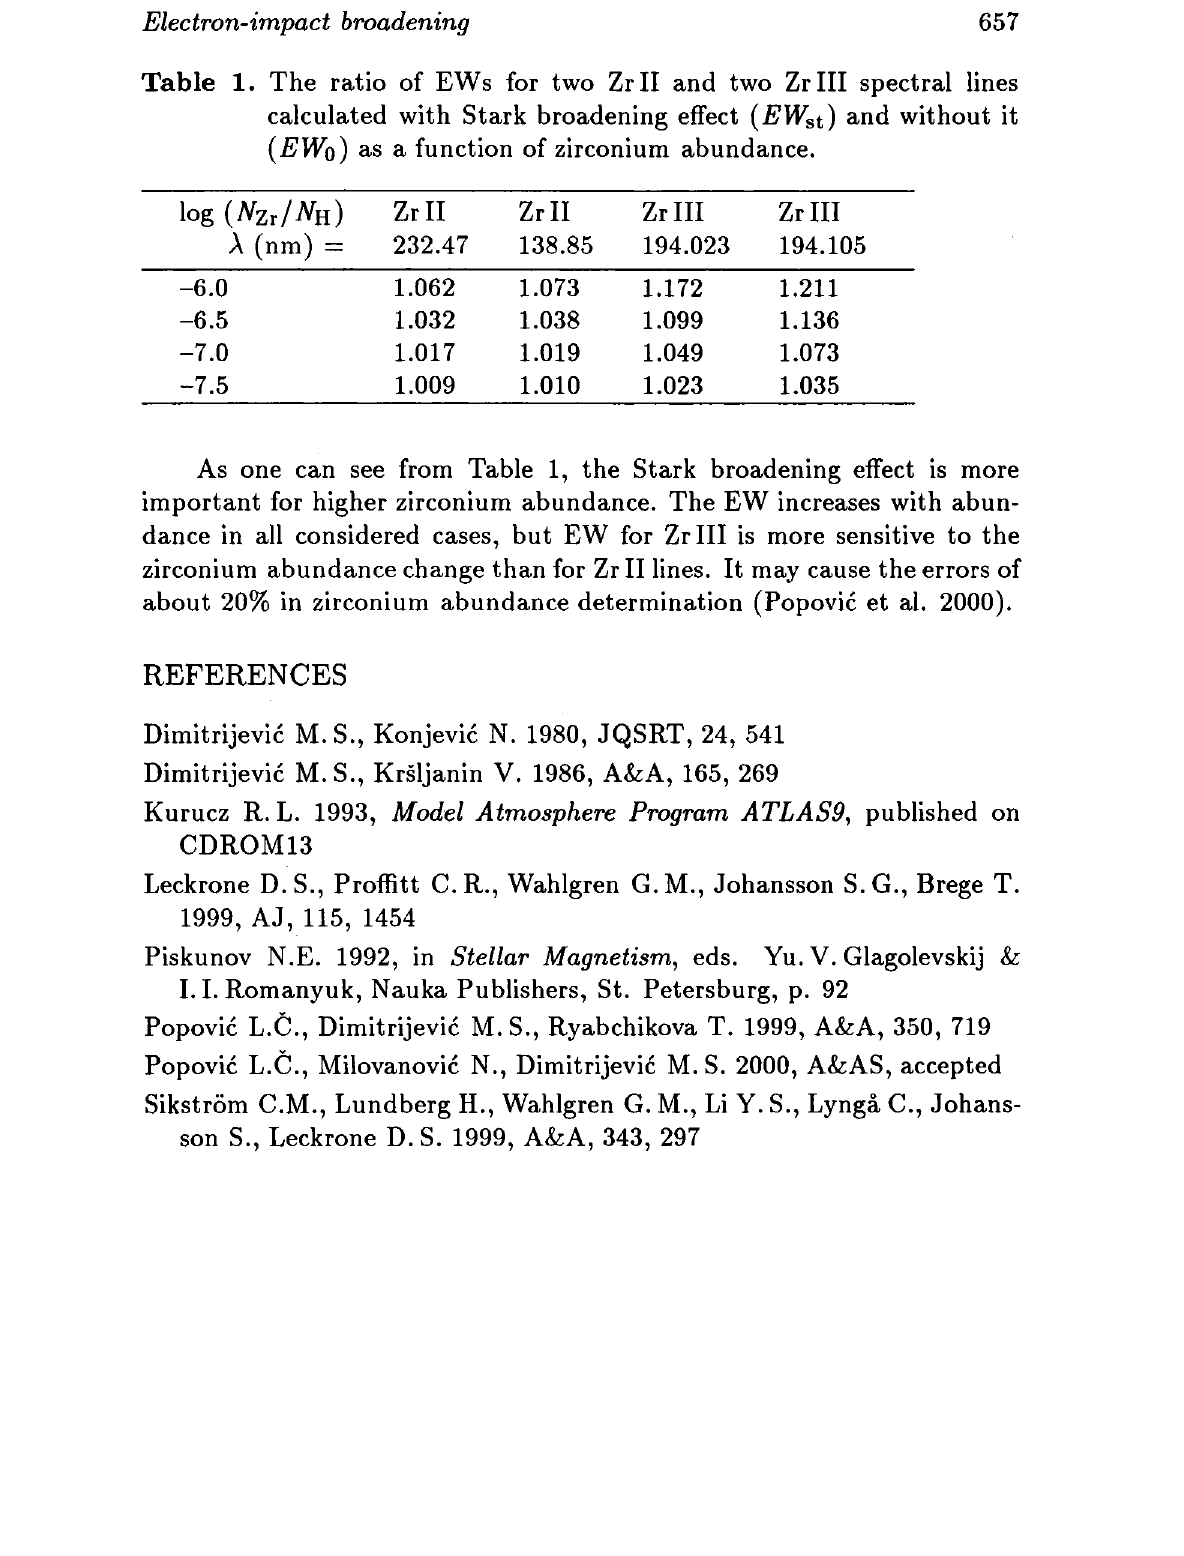
Table 1. The ratio of EWs for two Zrll and two Zr III spectral lines calculated with Stark broadening effect (£W (EWQ) as a function of zirconium